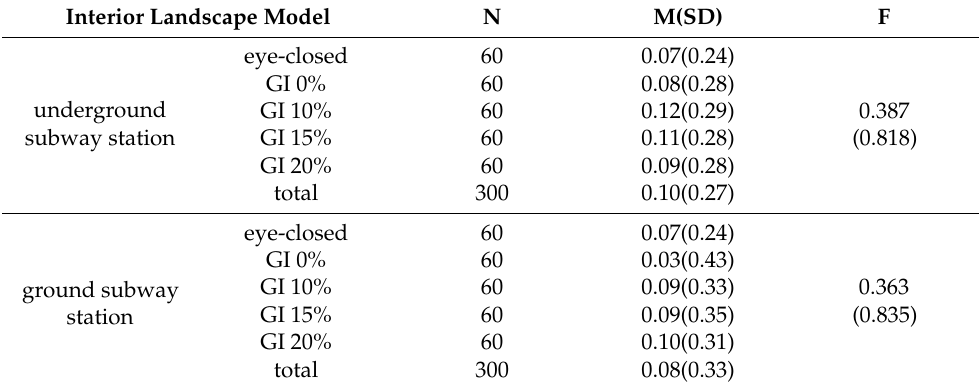
Table 4. Prefrontal High β wave Asymmetry of Subway Interior Landscape Models with GI.